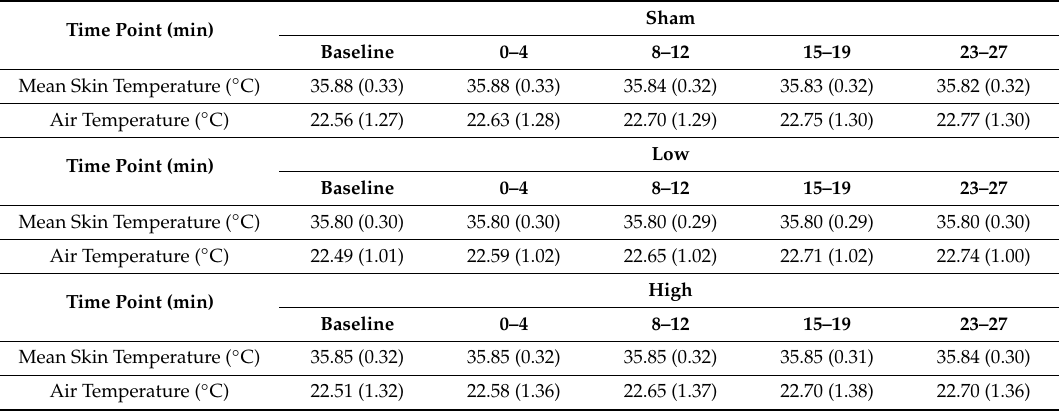
Table 1. Mean ambient temperature and mean skin temperature at Baseline and throughout exposure for the Sham, Low, and High exposure conditions (standard errors in